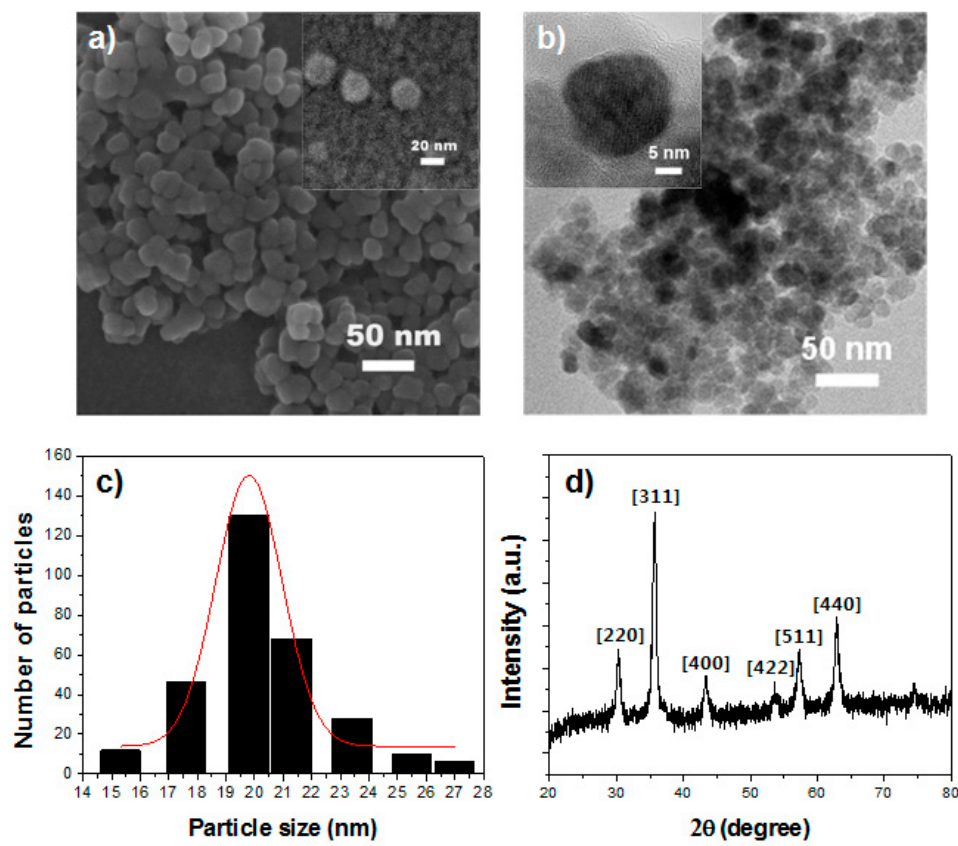
Figure 1. Structural analysis of the cholrin6- and folic acid-conjugated magnetite (Fe 3 O 4 -Ce6-FA) nanoparticles. ( a ) Field emission scanning electron and ( b ) transmission electron micrographs of the Fe 3 O 4 -Ce6-FA nanoparticles; ( c ) histogram of particle size distribution; ( d ) X-ray diffraction pattern of the Fe 3 O 4 -Ce6-FA nanoparticles.